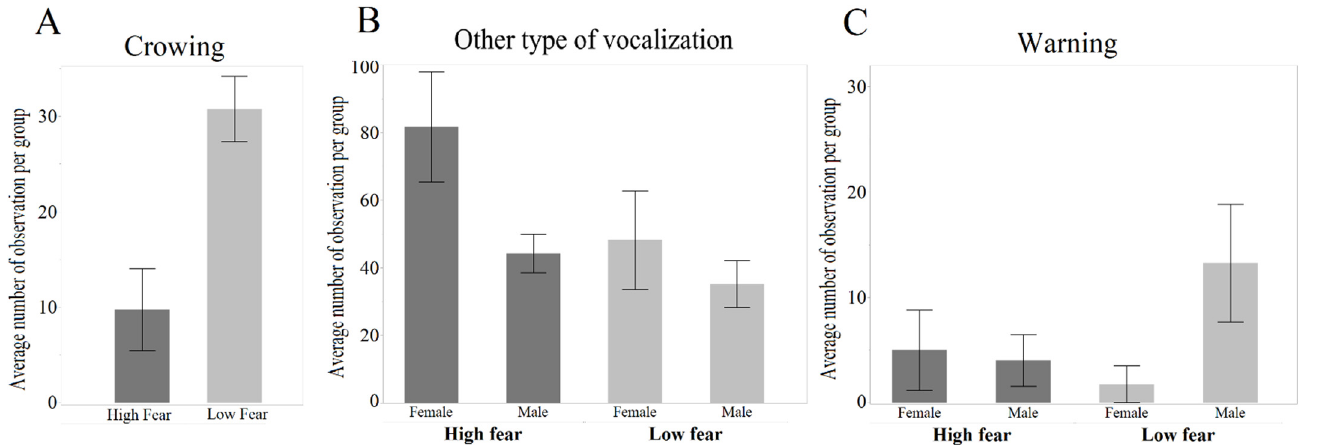
Figure 5. Frequencies of vocalizations in the two selection lines, separated by sex (mean ± SE). ( A ) Average number of Crowing (males only) per group. ( B ) Average number of other vocalizations. ( C ) Average number of warning calls.